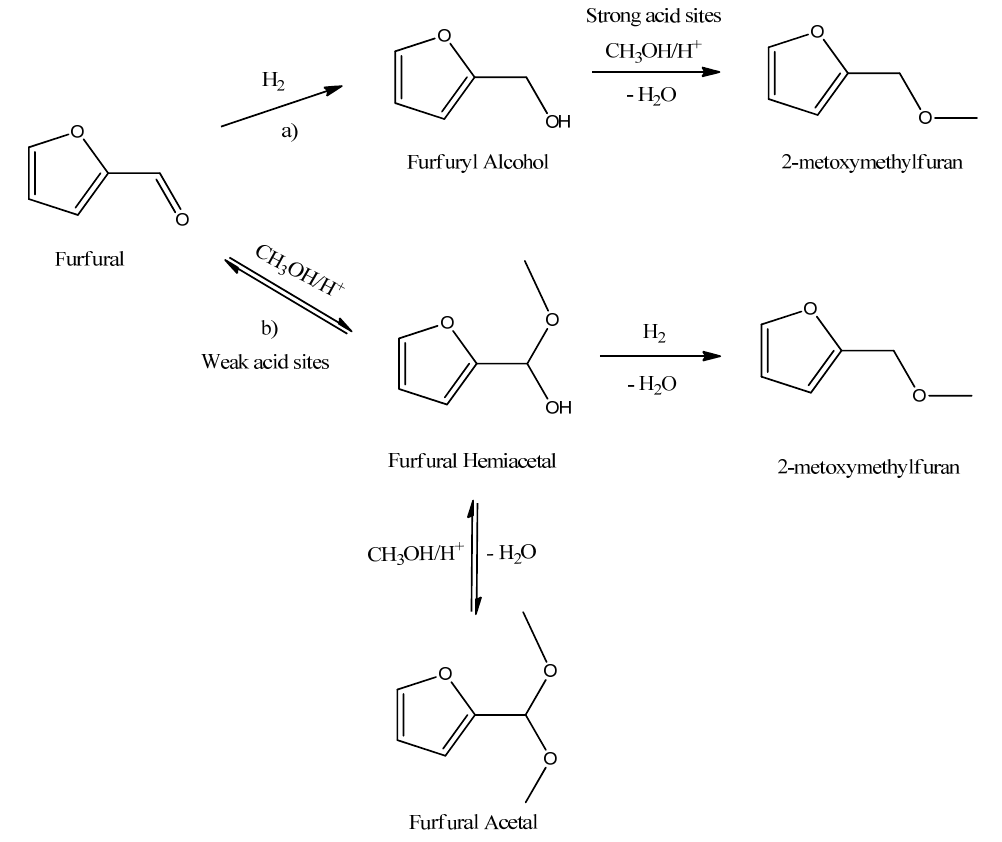
Scheme 2. The two proposed pathways for the reductive etherification of